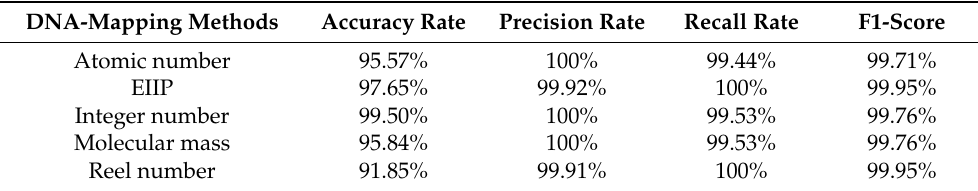
Table 3. Classification performances of DNA-mapping